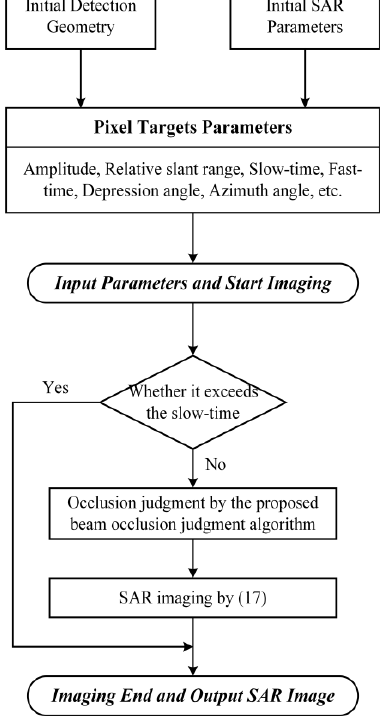
Figure 10. Flowchart of the proposed Topo-BPA for undulating terrain.